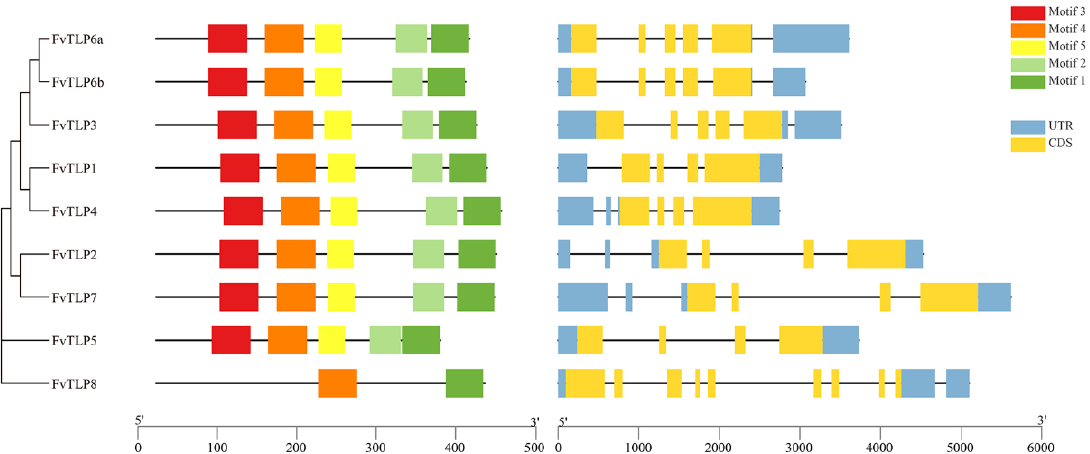
Figure 2. Conserved motif composition of FvTLPs and gene structure of FvTLP s. Distribution of conserved motifs in FvTLPs ( left ) and intron–exon structures of FvTLP genes ( right ). Rectangles of different colors represent different motifs, blue rectangles represent UTRs, black lines represent introns, and ginger rectangles represent exons.